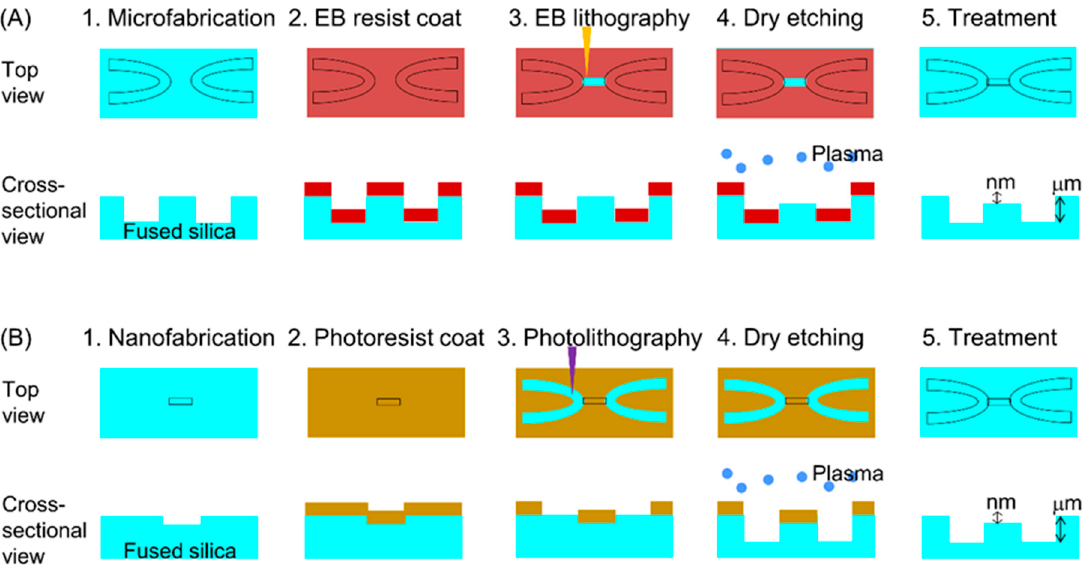
Schematic illustrations of the two micro-nano interface fabrication procedures. ( A ) Microchannels were firstly fabricated, and after that nanochannels were fabricated on the substrate. ( B ) Nanochannels were firstly fabricated, and after that microchannels were fabricated on the substrate.